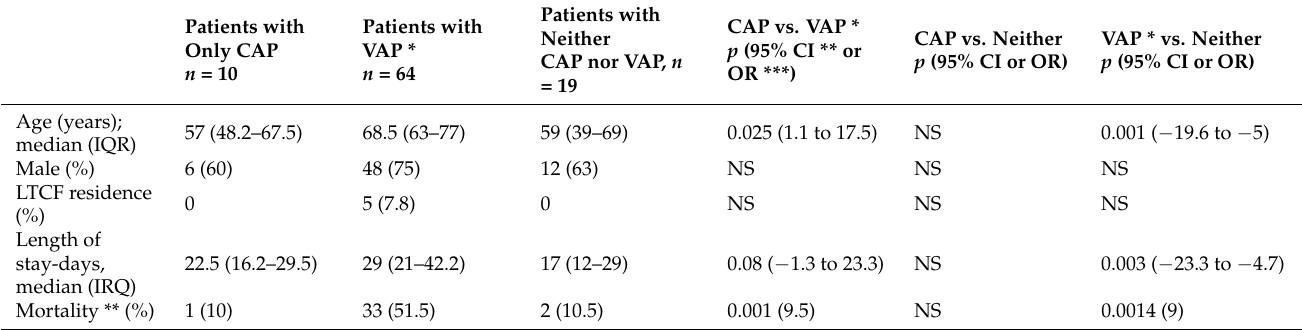
Table 2. Comparisons between patients’ characteristics and outcomes according to diagnosis of pneumonia using the less strict set of